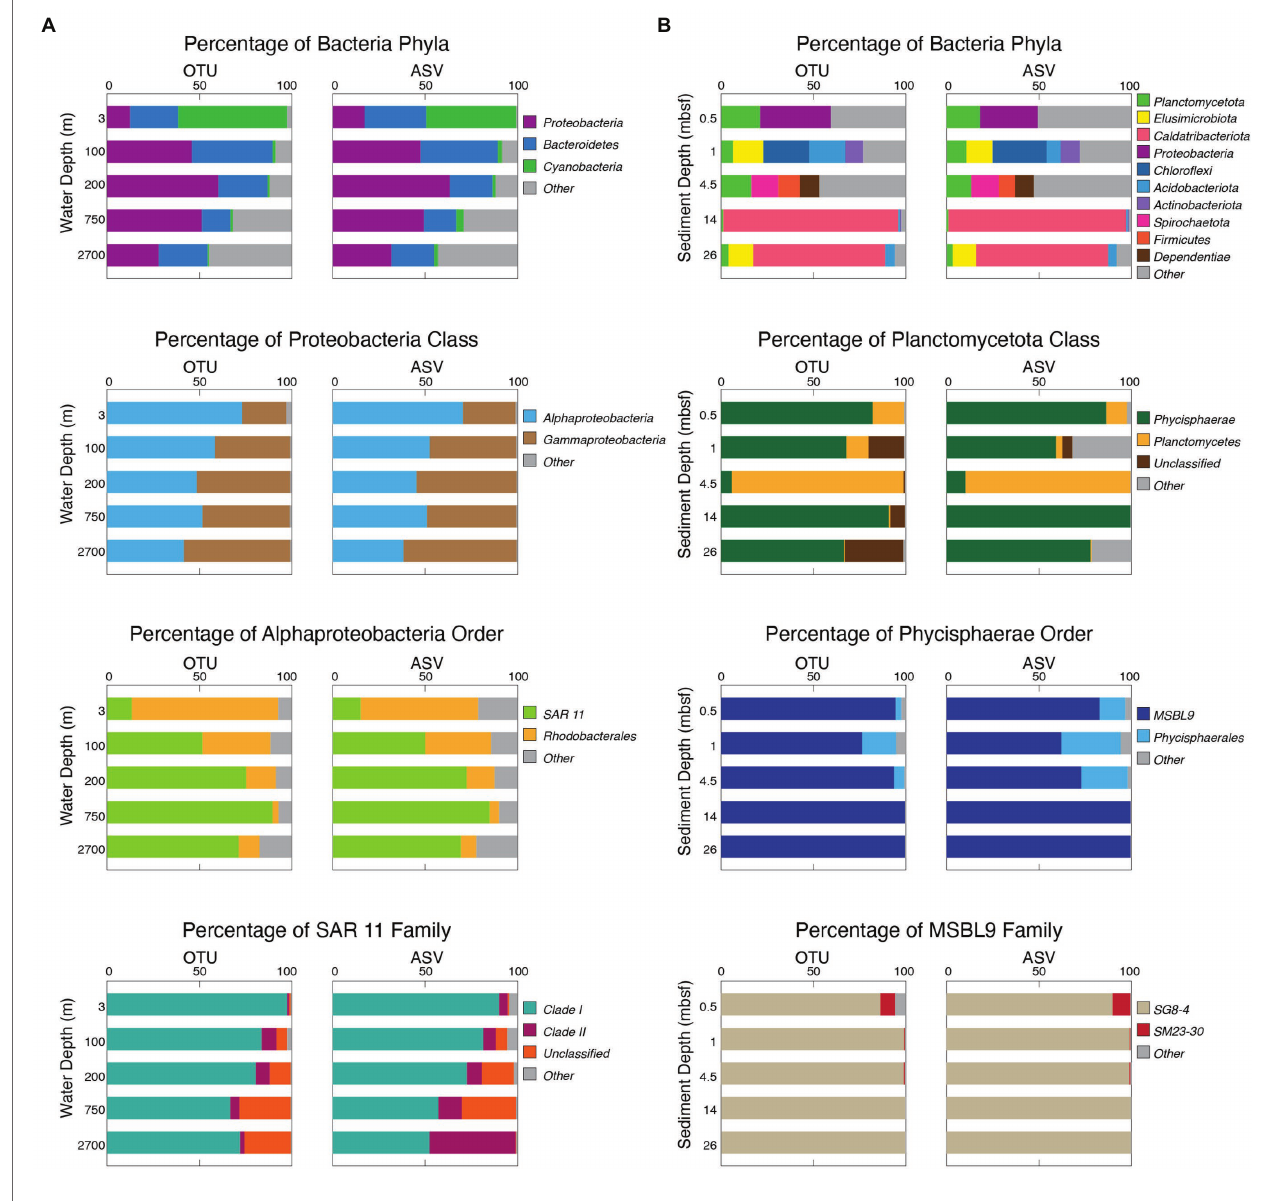
FIGURE 6 | Bacterial community composition as analyzed with both OTUs and ASVs in the water column and marine sediment. (A) Water column community composition of the Bacteria domain, Proteobacteria phylum, Alphaproteobacteria class, and SAR 11 order with OTUs (left) and ASVs (right). (B) Marine sediment community composition of the Bacteria domain, Planctomycetota phylum, Phycisphaerae class, and MSBL9 order with OTUs (left) and ASVs